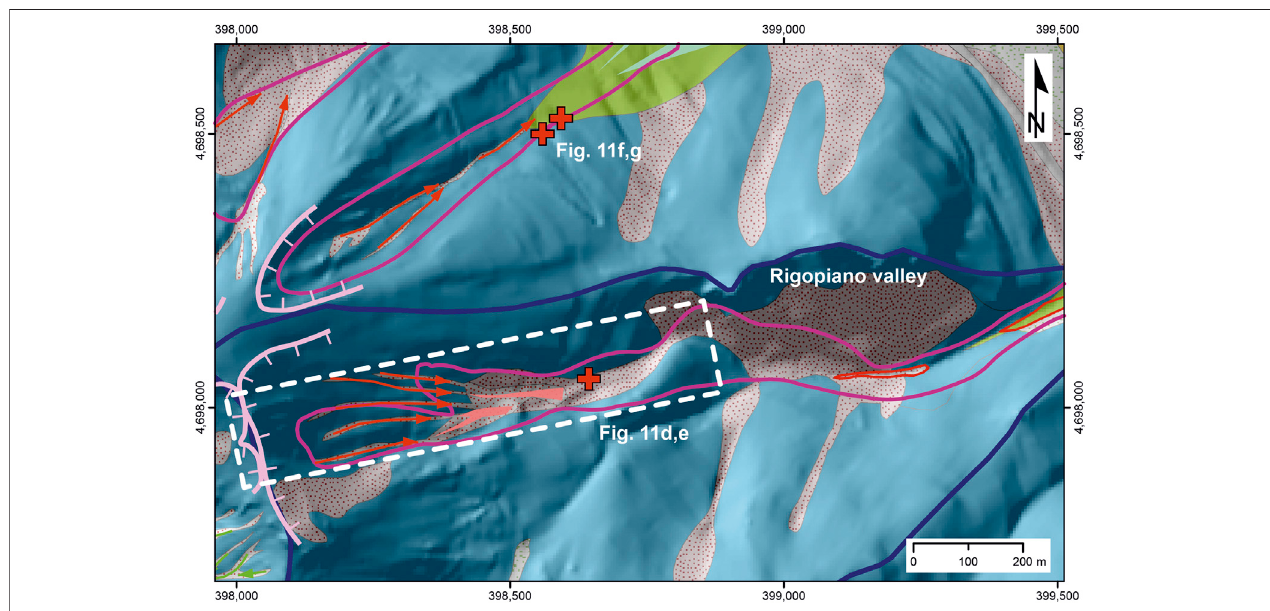
FIGURE 12 | Geomorphological scheme of the Rigopiano avalanche detachment area (zoom of Figure 10 ). For the legend, see Figure 10 ; the red crosses mark the co-seismic fractures and scarps ( Figures 11D – G ).